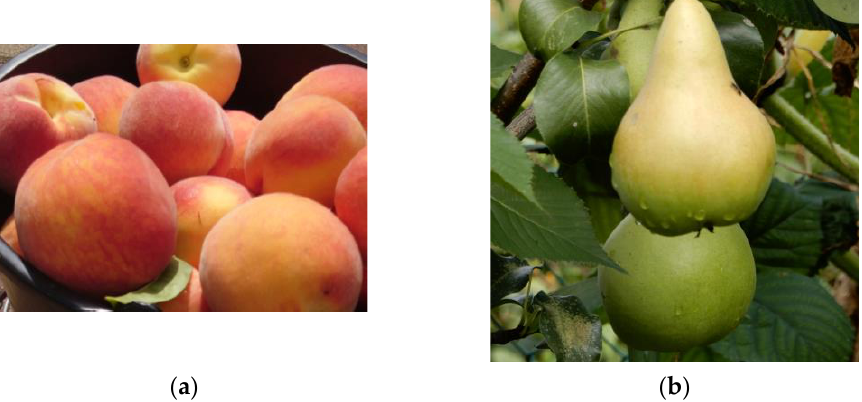
Figure 1. The organic fruits used for juice preparation were: ( a ) late peach and ( b ) winter pear. Preparation of Fruit